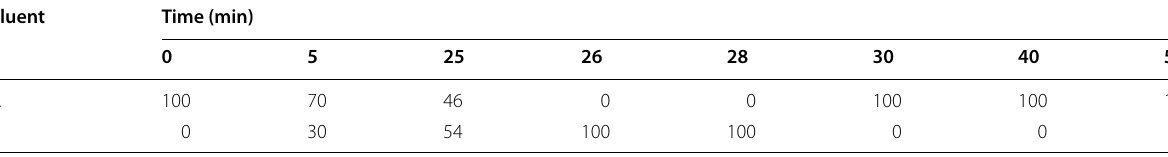
Table 2 Gradient elution program